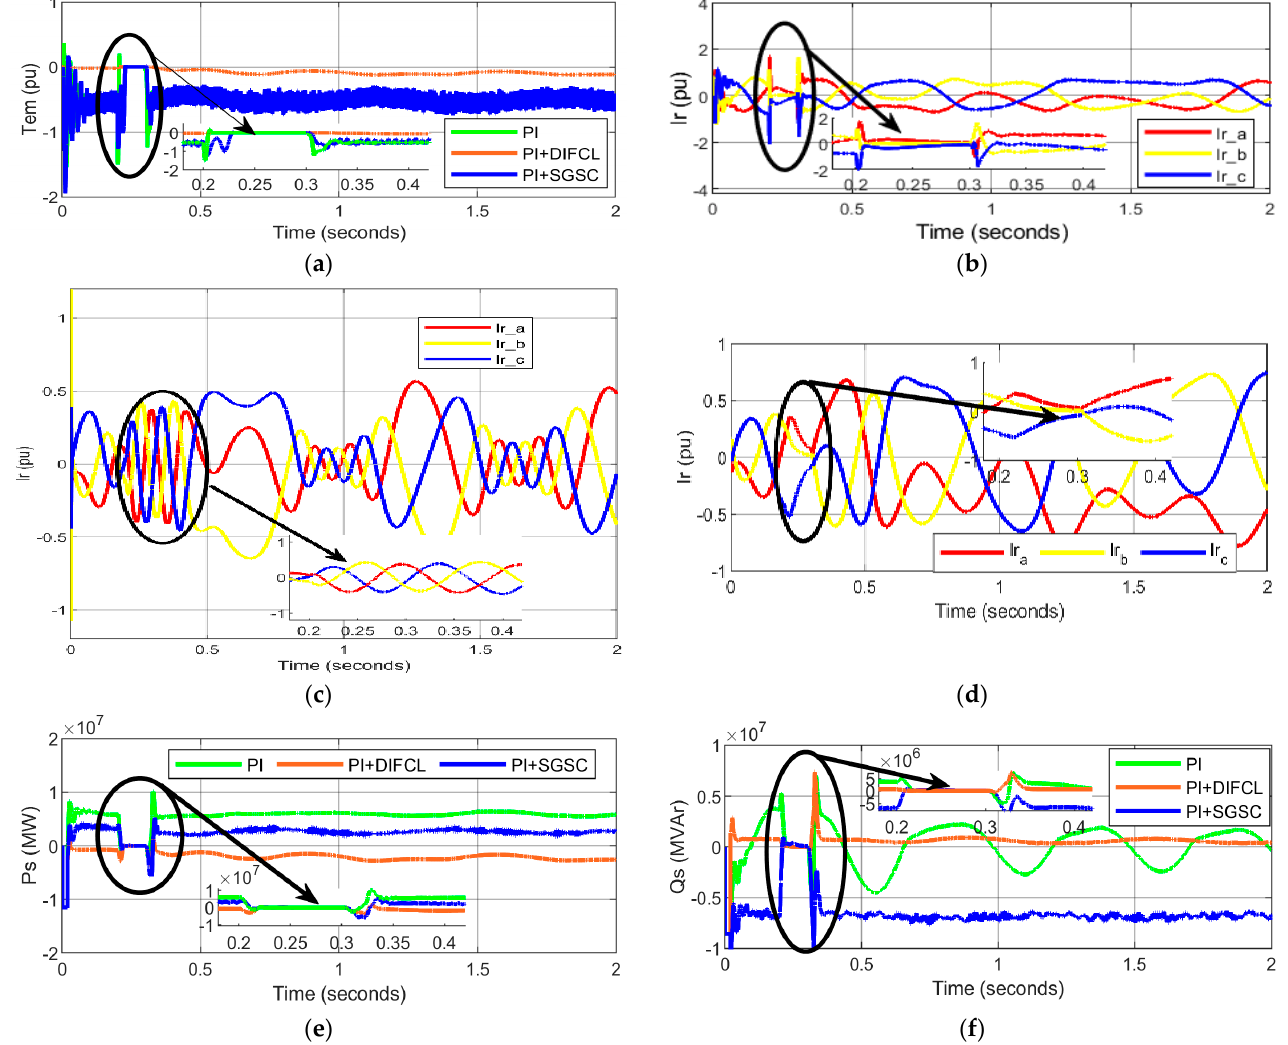
Figure 8. Behavior of DFIG-based WECS during three-phase fault with shunt-transformer-interfaced auxiliary SGSC. ( a ) Per unit electromagnetic torque; ( b–d ) per unit rotor currents; ( e ) stator active power (MW); ( f ) stator reactive power (MVAr).